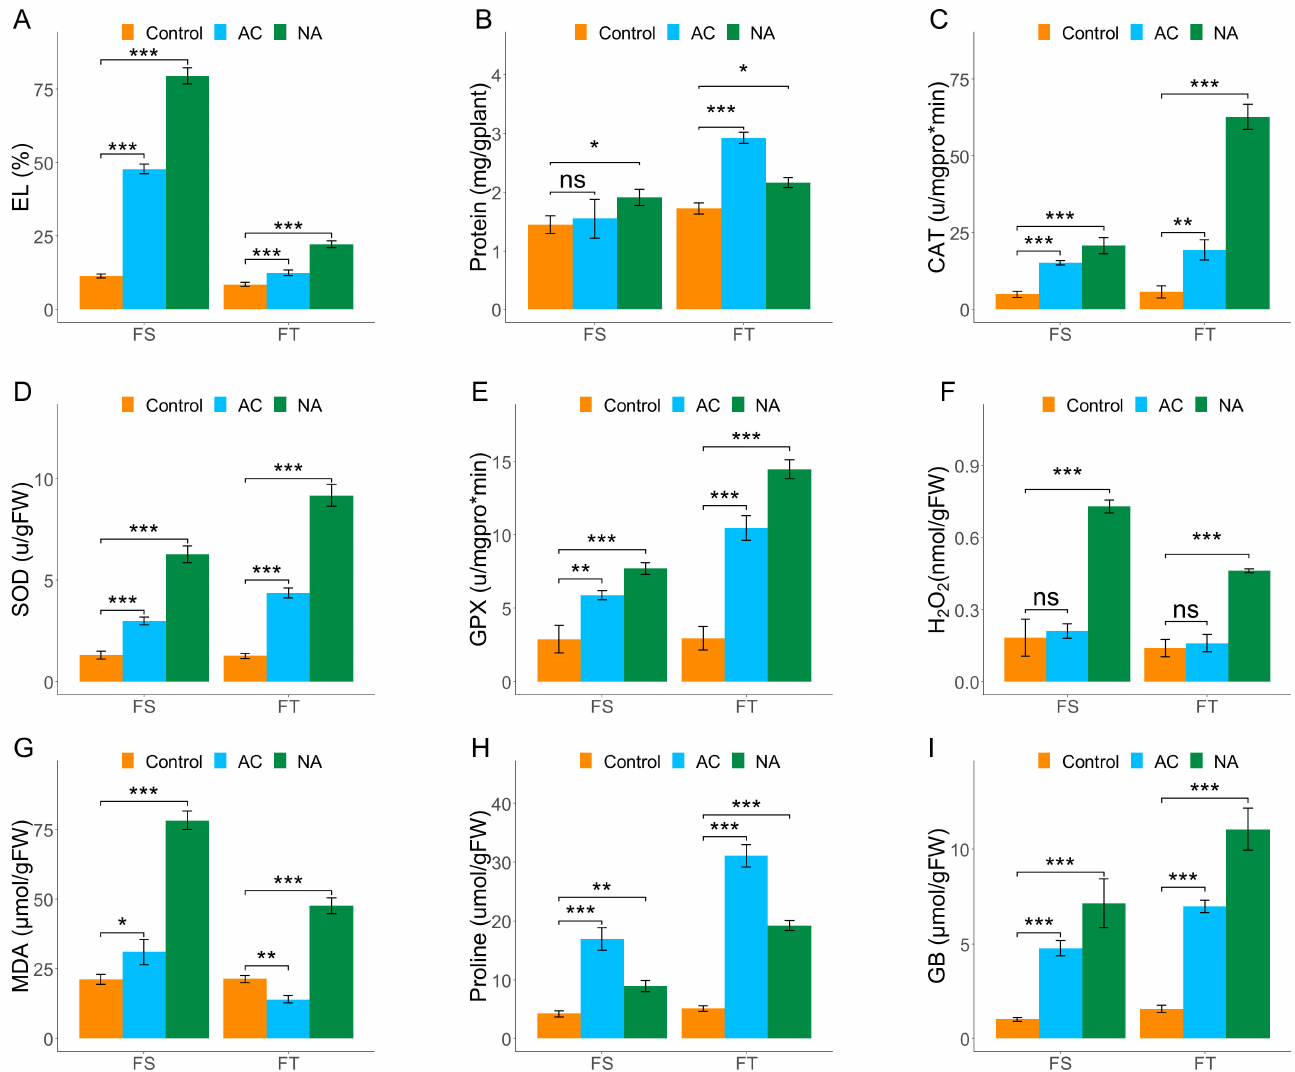
Figure 1. The effect of freezing stress on biochemical properties of two Camelina biotypes (freezing sensitive (FS) and freezing tolerant (FT)) with (AC) and without cold acclimation (NA). EL: electrolyte leakage; CAT: catalase; SOD: superoxide dismutase; GPX: guaiacol peroxidase; MDA: malondi- aldehyde; GB: glycine betaine. The ns, *, **, and *** show non-significant differences or significant differences at p ≤ 5%, 1%, and 0.1%, respectively. The synteny of the selected ICE-CBF-COR genes in A. thaliana and C. sativa is repre- sented in Figure 3. Synteny analysis of the CsICE1 , CsCBF1 , CsCBF2 , CsCBF3 , and CsCOR6.6 genes in comparison to A. thaliana genome showed that gene copies of C. sativa were located on G1, G2, and G3 sub-genomes of C. sativa (presented in different green colors in Figure 3). For example, AtICE1 , which is located on chromosome 4 in A. thaliana , was detected on chromosomes 4 (G1), 6 (G2), and 9 (G3) of C. sativa , reflecting the more copy numbers of these genes as a result of gene